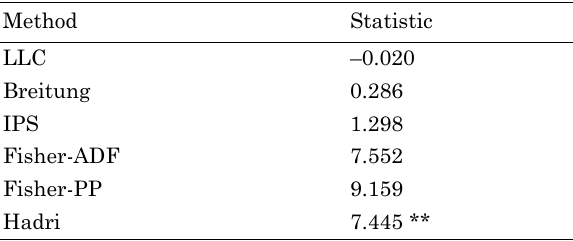
Table 2. Panel unit root and stationary tests